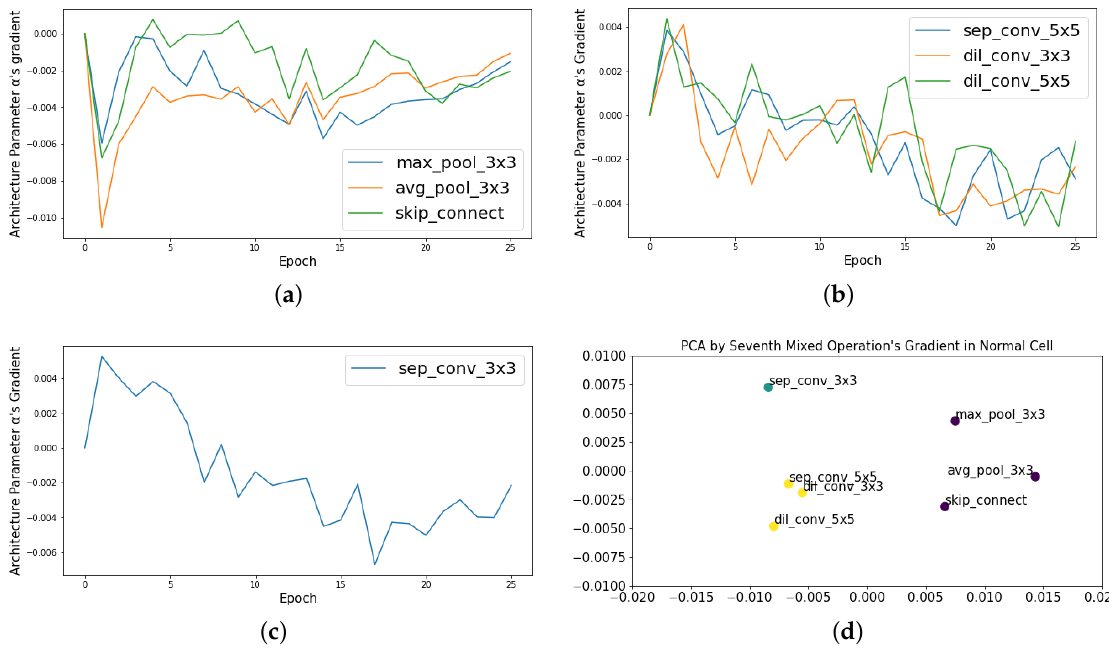
Figure 6. Gradient over stage 1 epoch progression: seventh mixed operation of cell. ( a ) Cluster 1: Seventh mixed operation’s gradient in a normal cell. ( b ) Cluster 2: Seventh mixed operation’s gradient in a normal cell. ( c ) Cluster 3: Seventh mixed operation’s gradient in a normal cell. ( d ) PCA by seventh mixed operation’s gradient in a normal